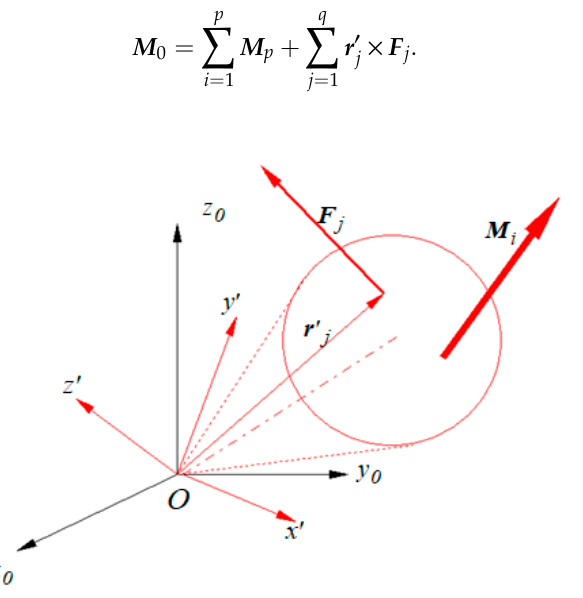
Figure 4. Conical pendulum.